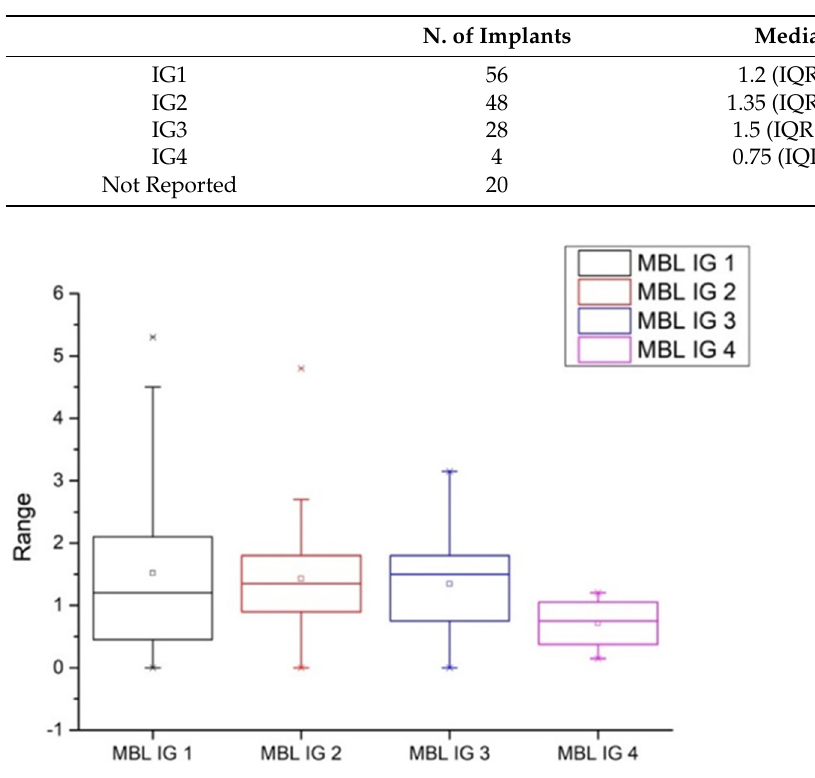
Figure 7. Distribution and IQR of MBL associated to plaque scores assigned. Table 3. Hygiene index and MBL with inter quartile ranges (IQR).